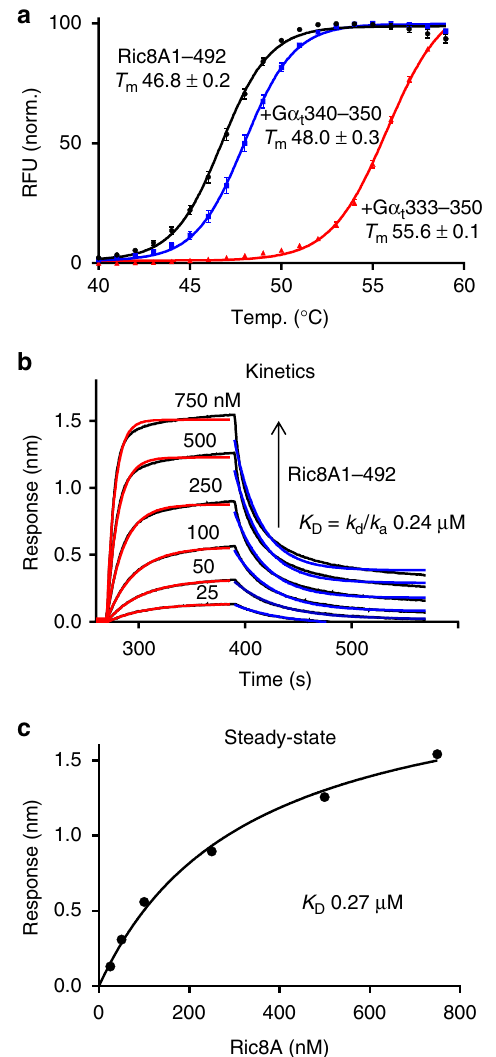
Fig. 1 Interaction of Ric8A with the C-terminus of G α . a Thermal denaturation, as determined by differential scanning fl uorimetry (DSF), of 8.7 µ M Ric8A1 – 492 in the absence (black) or presence of 50 µ M G α t 340 – 350 (blue) or G α t 333 – 350 (red). RFU – relative fl uorescence units. Average normalized curves are shown. The T m values (°C) are shown as mean ± SD ( n = 3). b Kinetics of association and dissociation for Ric8A1 – 492 and biotinylated G α t 333 – 350 coupled to a streptavidin biosensor as determined using BLI. Representative curves are shown. The processed data curves are black and the nonlinear regression fi ts from the 1:1 binding model are red (association; k a = 1.3 ± 0.3 × 10 5 M − 1 s − 1 ) and blue (dissociation; k d = 0.031 ± 0.008s − 1 ) (mean ± SD). c The steady-state binding curve obtained from data in (b); K D = 0.27 μ M. For n = 4 experiments, K D = 0.28± 0.07 μ M (mean ± SD). Source data are provided